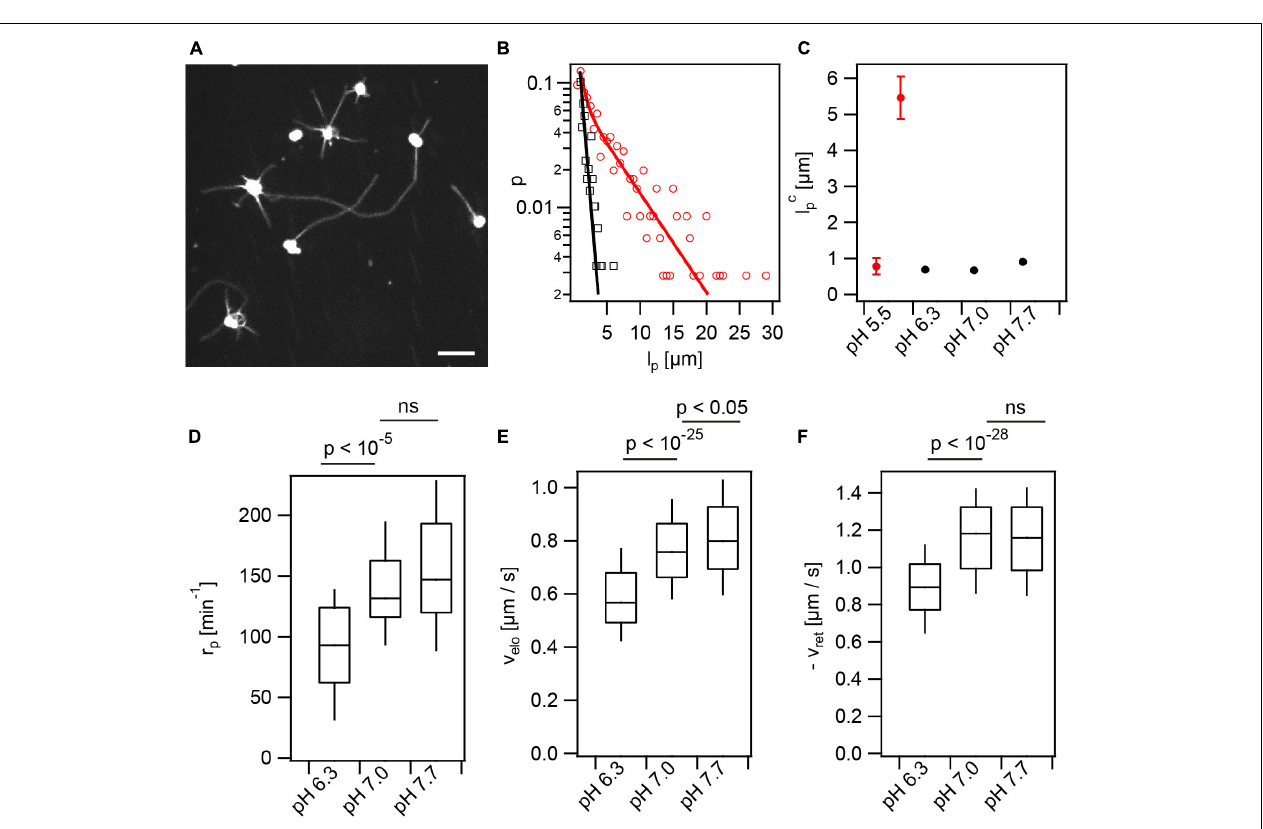
FIGURE 5 | Hydrogen peroxide reduces T4P production rate and T4P dynamics. Cells (Ng226) were treated with H 2 O 2 for 15 min. (A) Rate of T4P production, r p . ( > 40 cells for each condition) (B) T4P elongation velocities, v elo ( > 97 T4P for each condition). (C) T4P retraction velocities, v ret ( > 100 T4P for each condition). Shown are box: 25/75 percentiles, and median for 171 T4P. p -values obtained from KS test. (D) Characteristic maximal T4P length. ( > 340 T4P for each condition).